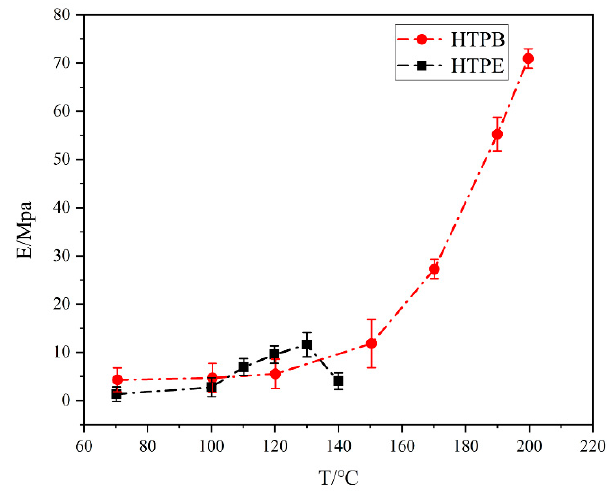
Figure 17. The relationship between modulus and temperature in HTPB and HTPE propellant.